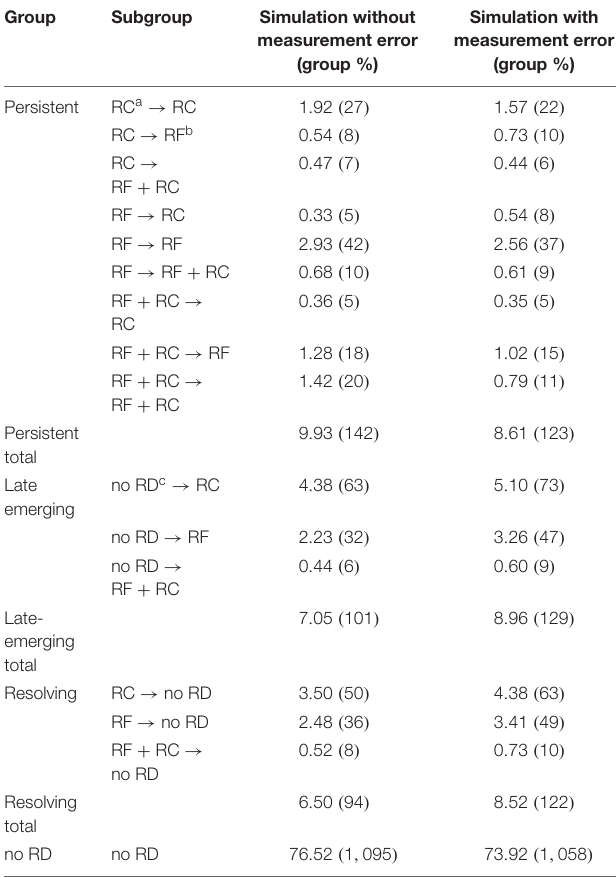
TABLE 6 | Percentages and number of individuals in reading difficulty (RD) groups identified with the use of a single cut-off. Group Subgroup Simulation without Simulation with measurement error measurement (group %)